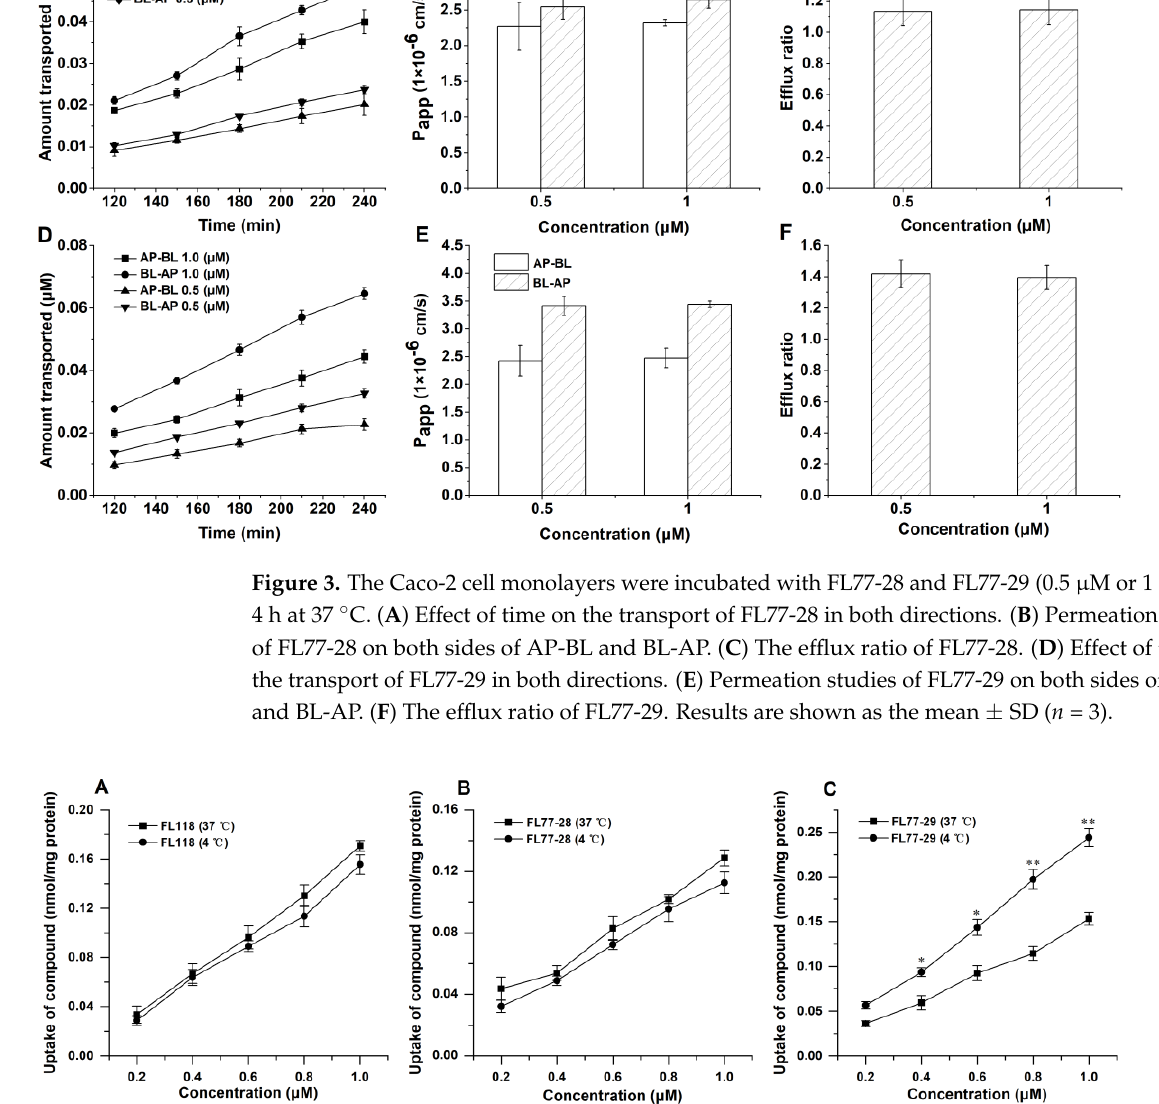
Figure 3. The Caco-2 cell monolayers were incubated with FL77-28 and FL77- 29 (0.5 μM or 1 μM) for 4 h at 37 ° C . ( A ) Effect of time on the transport of FL77-28 in both directions. ( B ) Permeation studies of FL77-28 on both sides of AP-BL and BL-AP. ( C ) The efflux ratio of FL77-28. ( D ) Effect of time on the transport of FL77-29 in both directions. ( E ) Permeation studies of FL77-29 on both sides of AP-BL and BL-AP. ( F ) The efflux ratio of FL77-29. Results are shown as the mean ± SD ( n = 3).